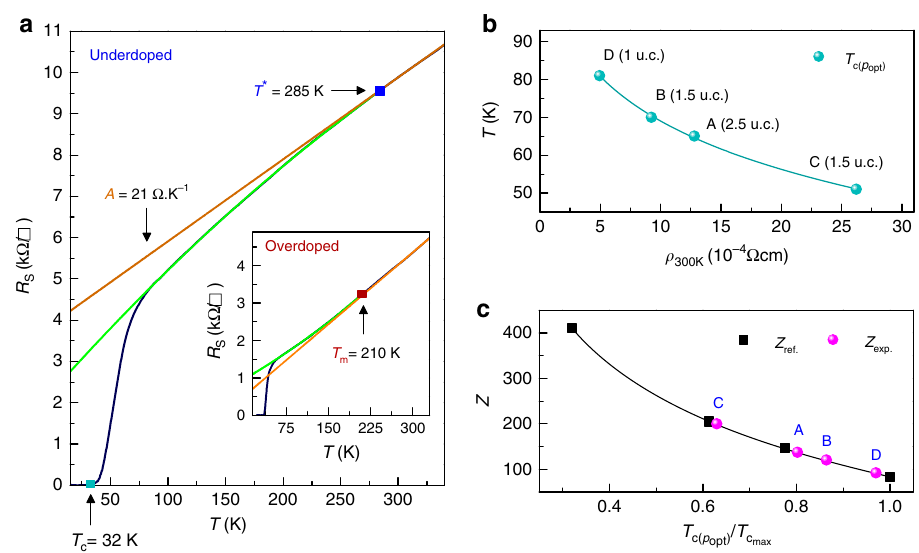
Fig. 2 Extraction of characteristic temperatures and parameters. a Sheet resistance as function of temperature of an underdoped device (overdoped in the inset). b Maximum T c of each device as a function of resistivity; T c ( p opt ) is the T c at the optimal doping level or the peak of the superconducting dome. c (cid:1) (cid:3) T ¼ 84 K is the maximum T = T Dependence of the scaling factor Z on T c p opt c measured by us to date in 2D BSCCO-2212 devices. The black c max , where c max line is a fi t to the data (black squares) of the measurements of Naqib et al. ( Z ref. ) 3 , while the magenta dots are the calculated values for the four devices of this work ( Z exp.